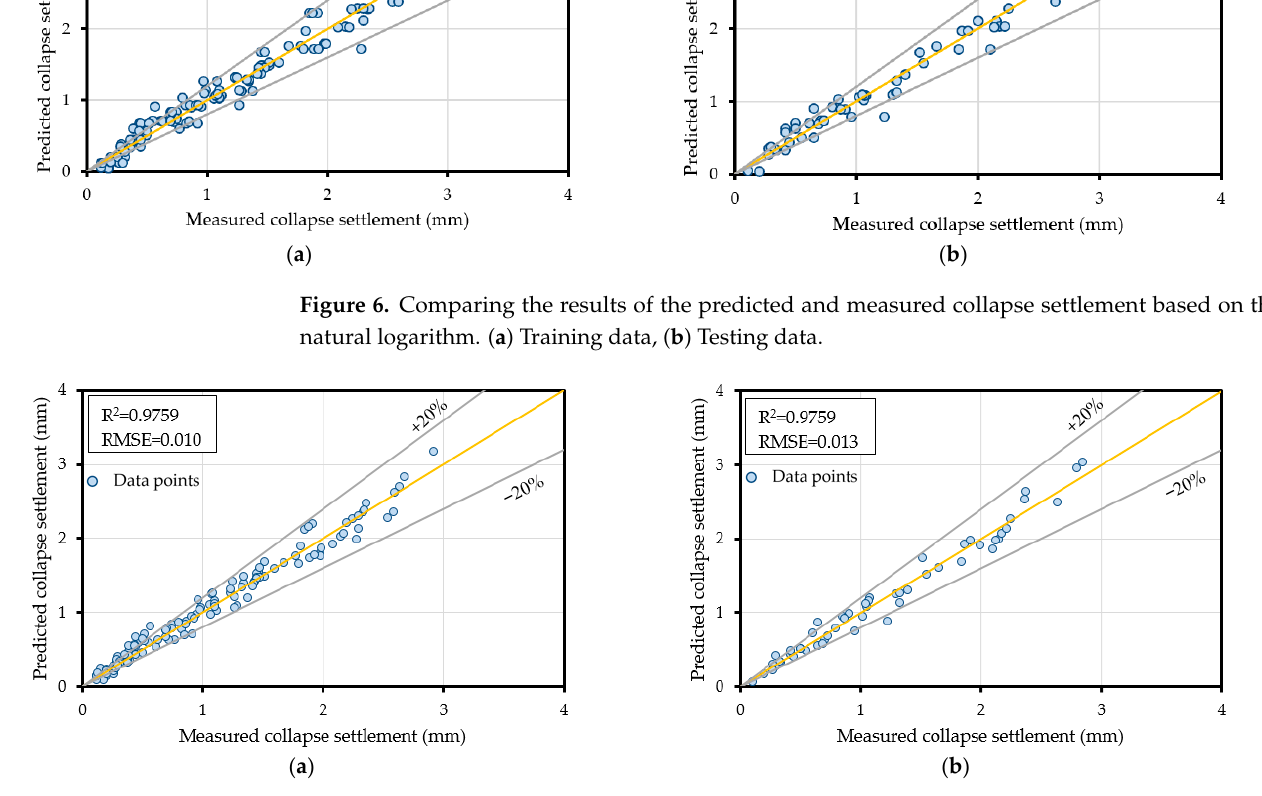
Figure 7. Comparing the results of the predicted and measured collapse settlement based on the exponential function. ( a ) Training data, ( b ) Testing data.